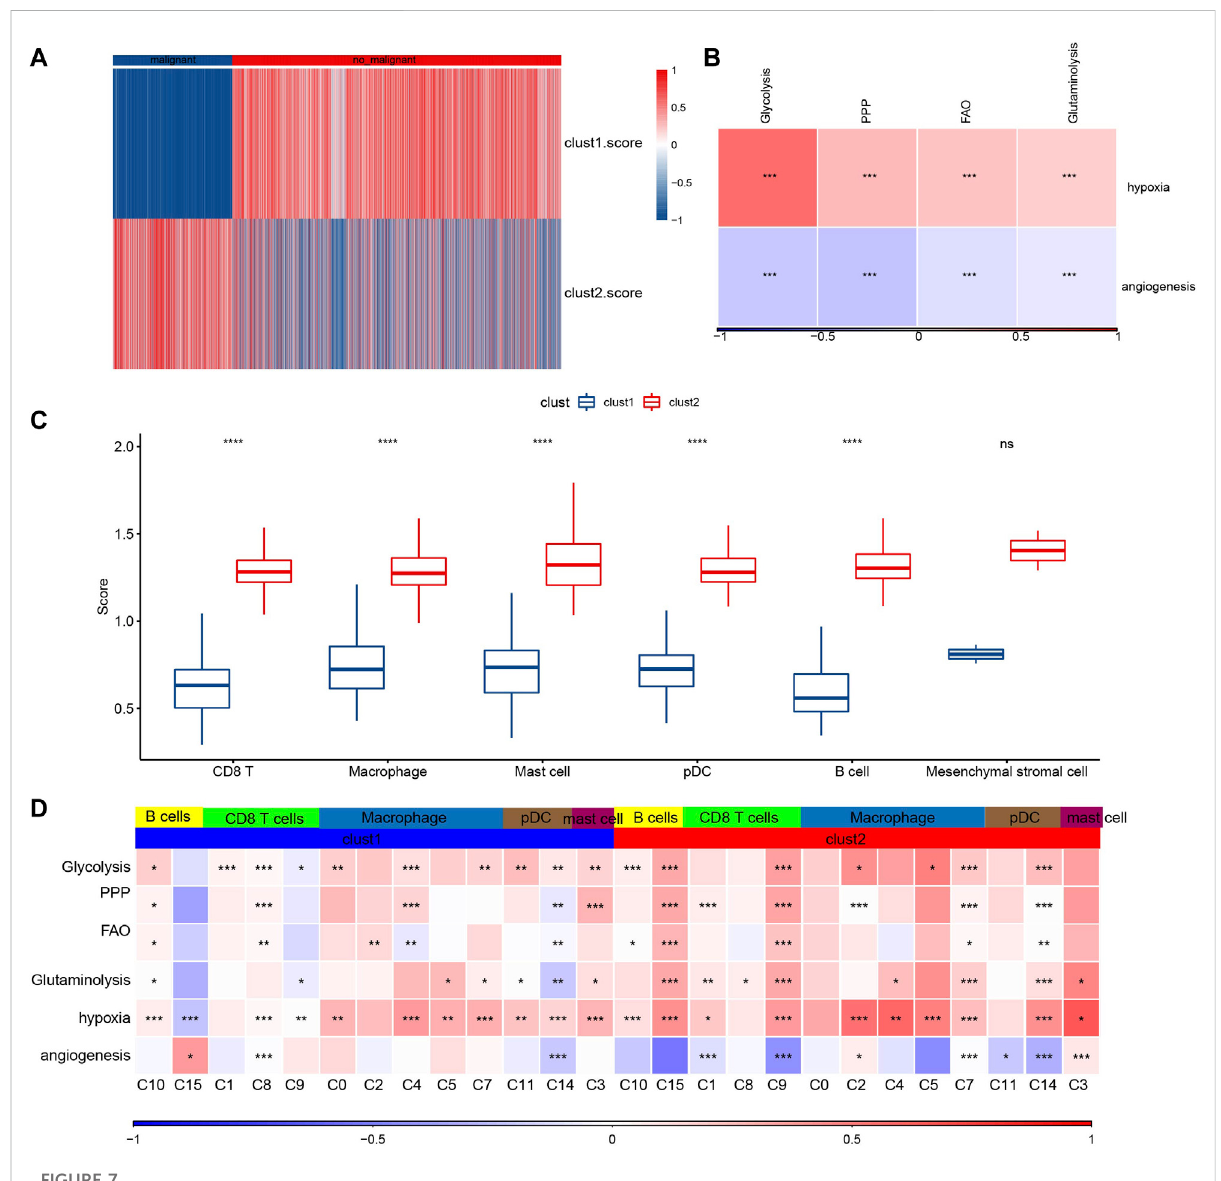
FIGURE 7 Composition and metabolism of malignant cells. (A) : The heat map shows the proportion of malignant and non-malignant cells between clusters 1 and cluster 2. (B) : The correlation between hypoxia score/angiogenesis score and four metabolic scores for malignant cells. (C) : The difference between the enrichment scores of six kinds of immune cells in cluster 2 and in cluster 1. (D) : Pearson correlation analysis showed the relation between 5 kinds of immune cells/15 subgroups in cluster 1 and cluster 2 and 4 metabolic patterns, hypoxia and angiogenesis, respectively. For this fi gure, the asterisks idicated the statistical p value, * p < 0.05, ** p < 0.01, *** p < 0.001, **** p <